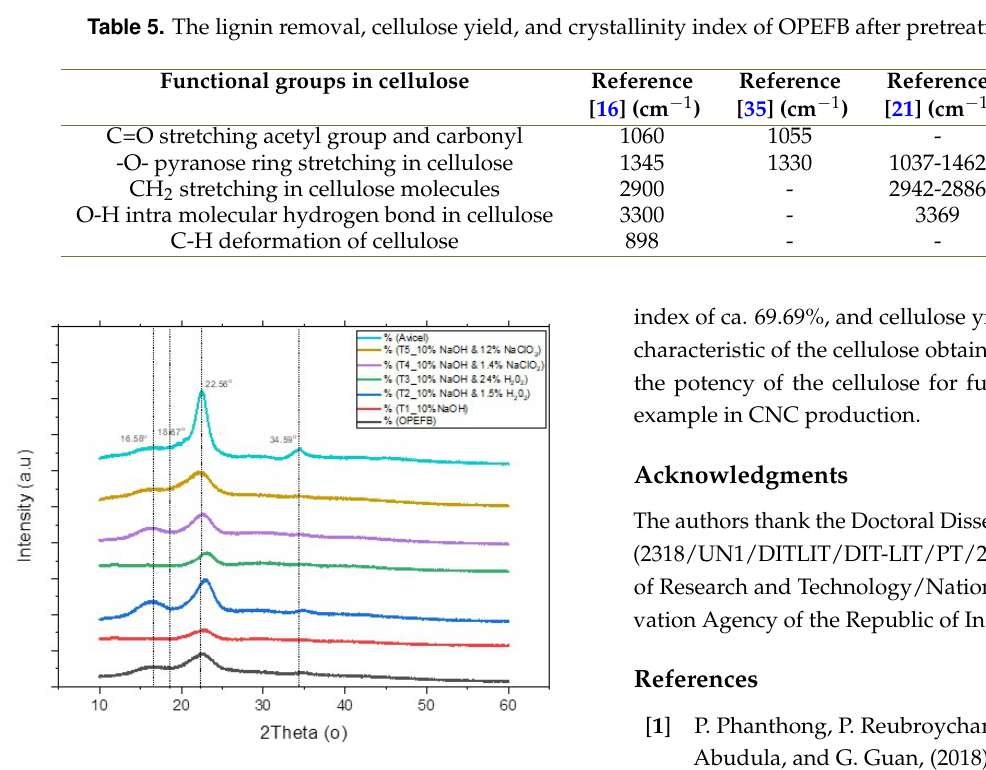
Fig. 4. X-ray diffractogram of untreated OPEFB; (T1) the pretreated OPEFB using NaOH 10%; (T2) using NaOH 10% and H 2 O 2 1.5%; (T3) using NaOH 10% and H 2 O 2 24%; (T4 ) using NaOH 10% and NaClO 2 1.4%; (T5) using NaOH 10% and NaClO 2 12%; and Avicel as a control.